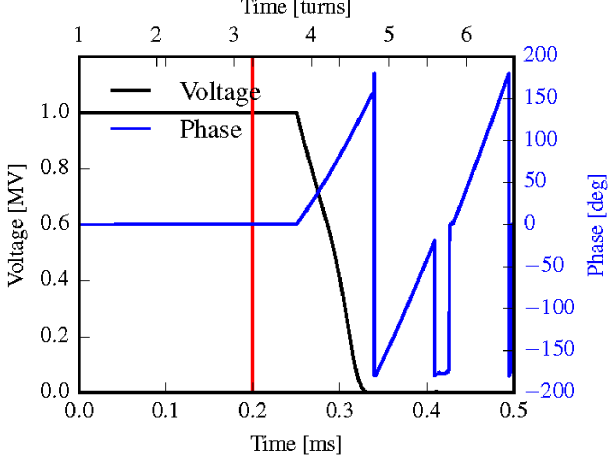
FIG. 5. Plot of the simulated cavity voltage and phase vs time during a quench for a KEKB-like cavity. The vertical red line represents the start time of the quench.